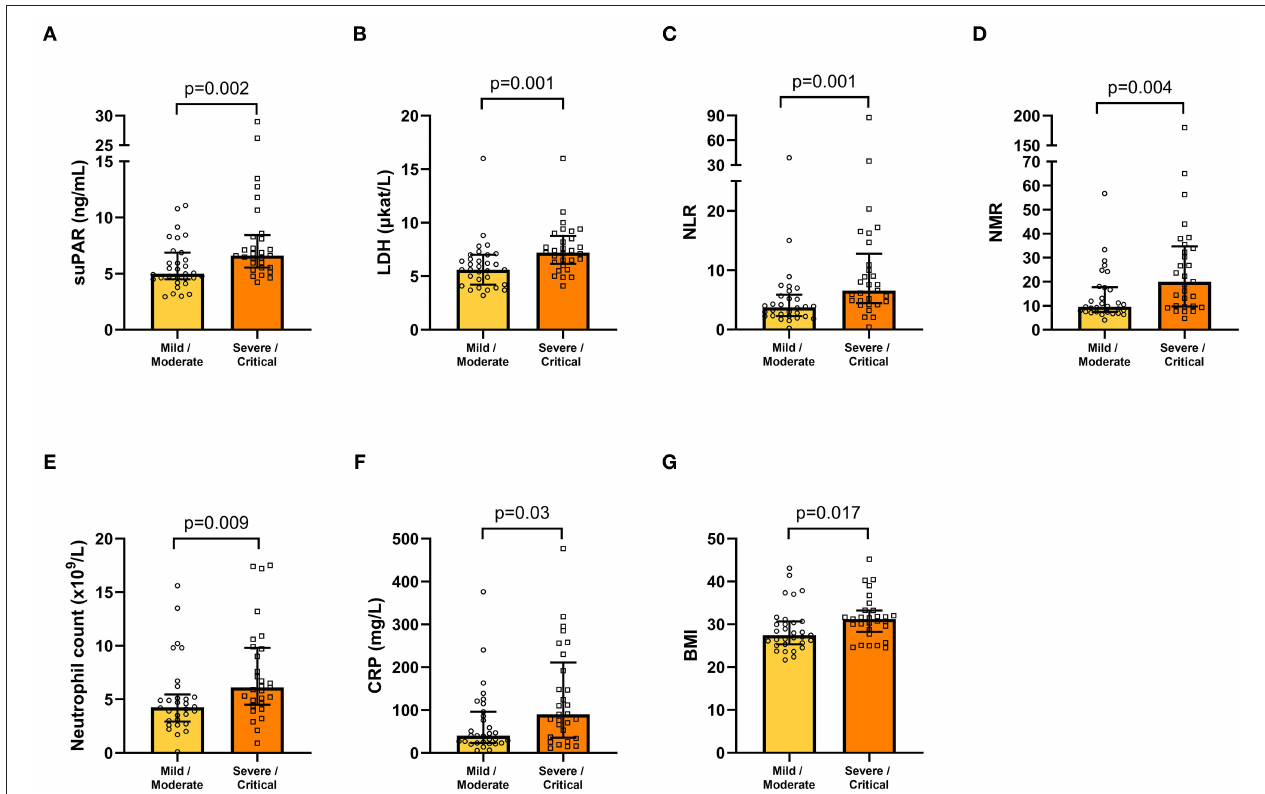
FIGURE 3 | Biochemical (A–F) and clinical (BMI; G ) variables, which are significantly increased in COVID-19 patients with severe/critical compared with mild/moderate illness. Bars and error bars represent median values and inter quartile range, respectively. Circles and squares represent individual values. BMI, body mass index; CRP, C-reactive protein; LDH, lactate dehydrogenase; NLR, neutrophil-to-lymphocyte ratio; NMR, neutrophil-to-monocyte ratio; suPAR, soluble urokinase plasminogen activator